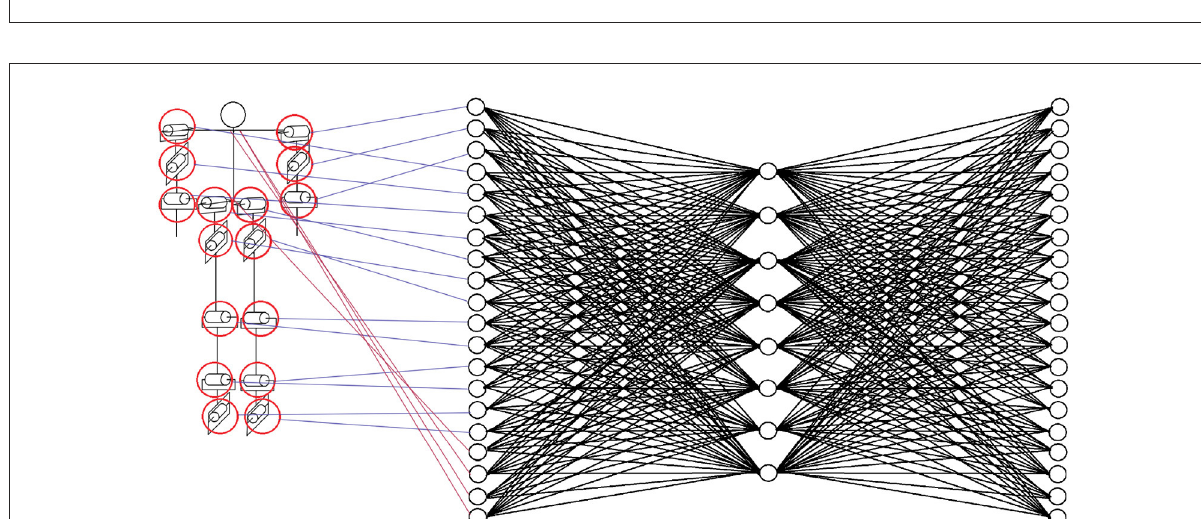
FIGURE4 Correspondence of each joint with each neuron in the input layer.